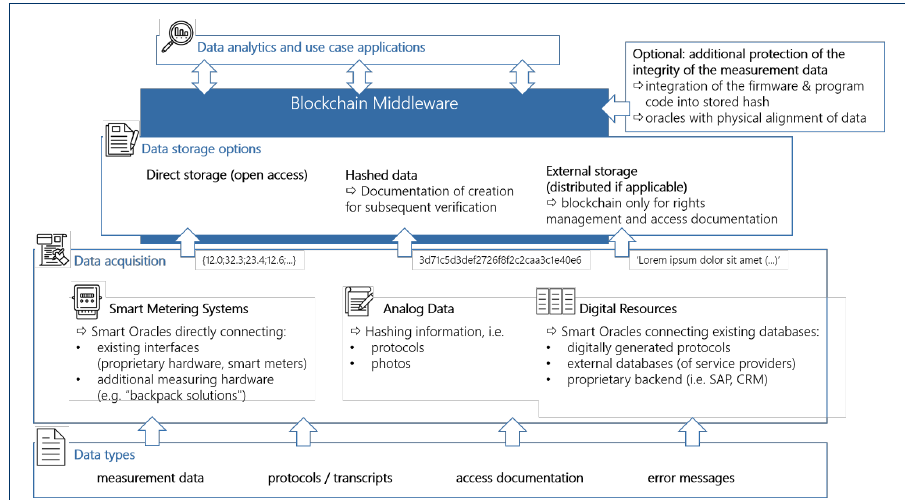
Figure 2 Technical concept of a blockchain-based Asset Logging platform